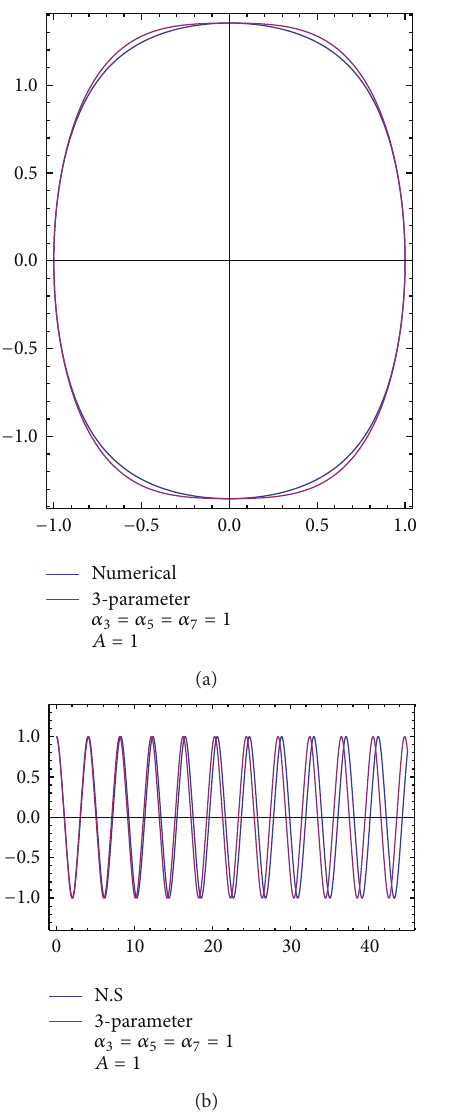
Figure 2: (a) Comparison for the 𝑢 versus ̇𝑢 trajectory for the case of 𝐴 = 1 and (b) 𝑡 versus 𝑢 (displacement 𝐴 = 1 ).